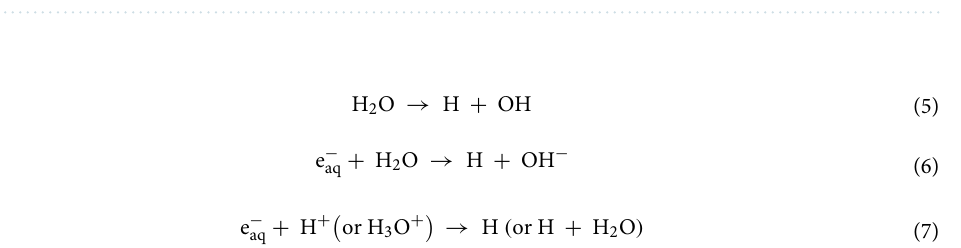
Table 2. Characteristics of some large TSP-derived